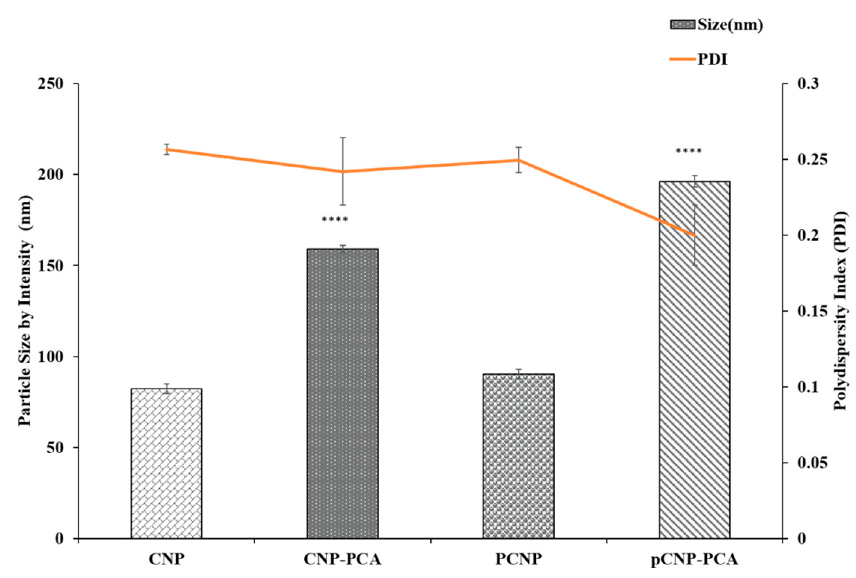
Figure 4. The expansion of nanoparticle size and PDI value after encapsulation. The results show that the size of empty nanoparticles expanded after encapsulation. Data are presented as mean ± SEM from three independent experiment replicates. One-way ANOVA was performed with **** p < 0.0001 indicating the significant difference in size between both CNP-PCA and pCNP-PCA with CNP and pCNP.